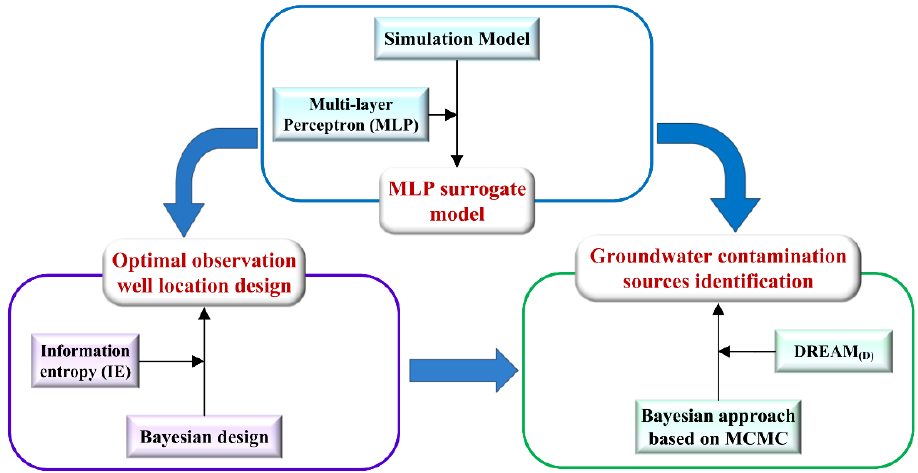
Figure 1. Flow diagram of research process.